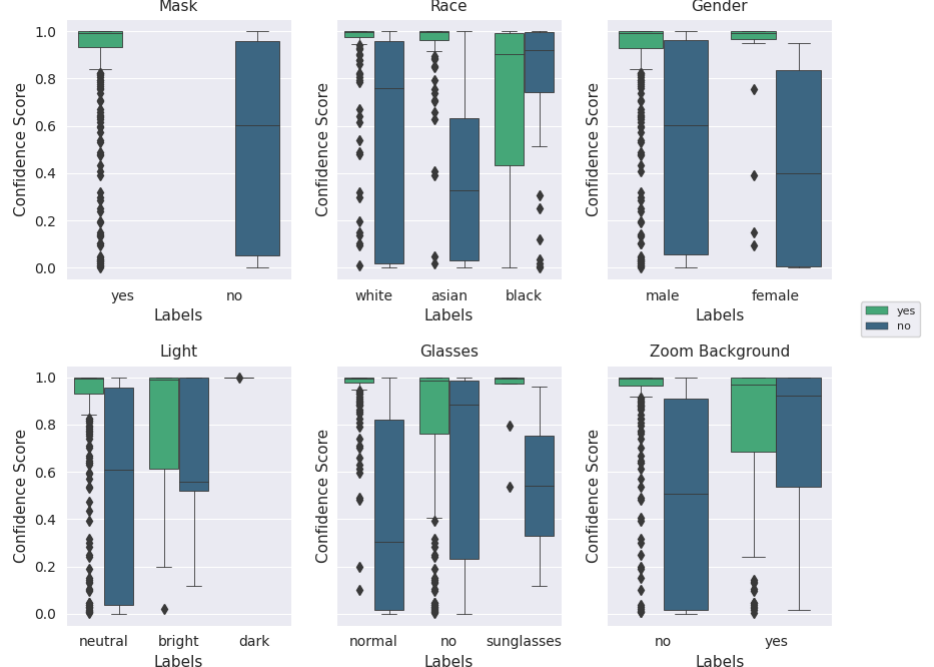
Figure A3. Box plot of categorical labels vs. confidence scores for only good quality images, as evaluated via BRISQUE using the augmented MobileNetv2 model. For each category and its labels, ‘mask’ and ‘no mask’ scores are plotted beside each other. The median is represented by the center line of each box while the upper and lower bounds represent the respective quartiles. Outliers are represented by diamond